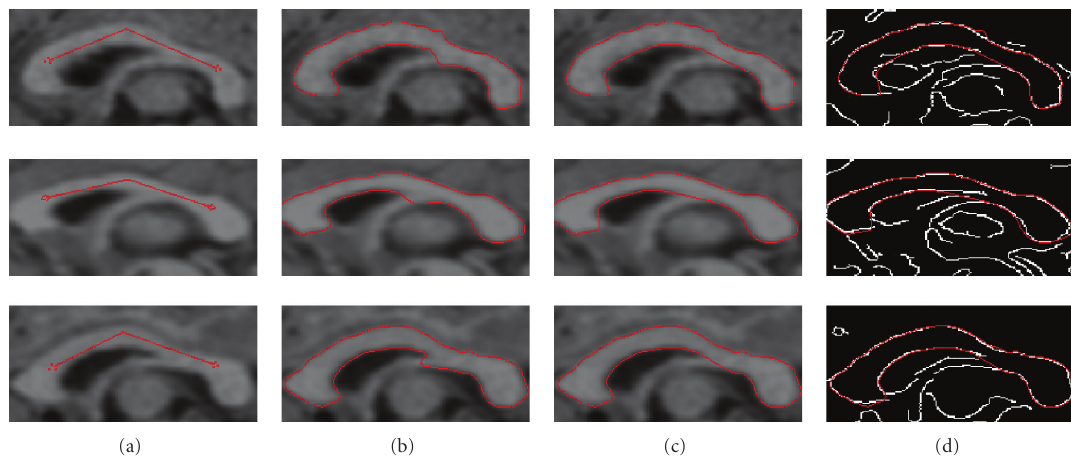
Figure 7: (a) The seed contour initialized by the user. (b) The fornix begins to appear without fornix removal. (c) The results with fornix removal. (d) The results overlaid on the edge map.